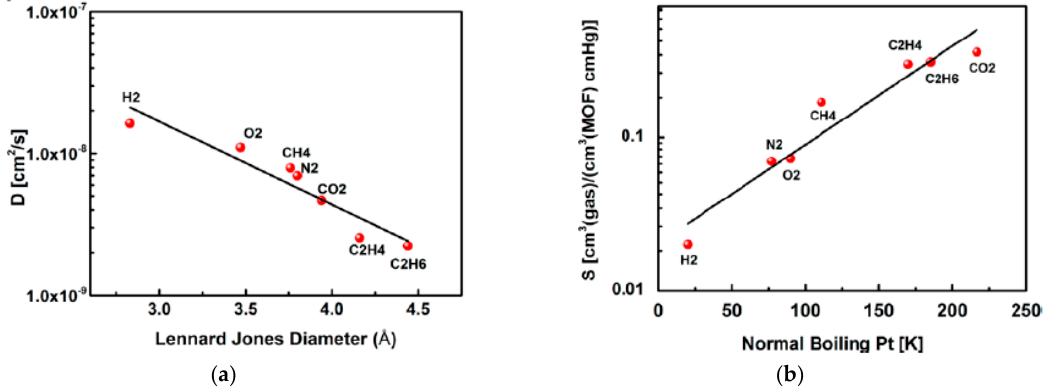
Figure 60. ( a ) Diffusion coefficients (D) vs. Lennard-Jones diameter. ( b ) Solubility coefficients (S) (from sorption data) vs. normal boiling point as determined from CV/VP permeation technique at 2 bar (adapted with permission from ref. [153]).